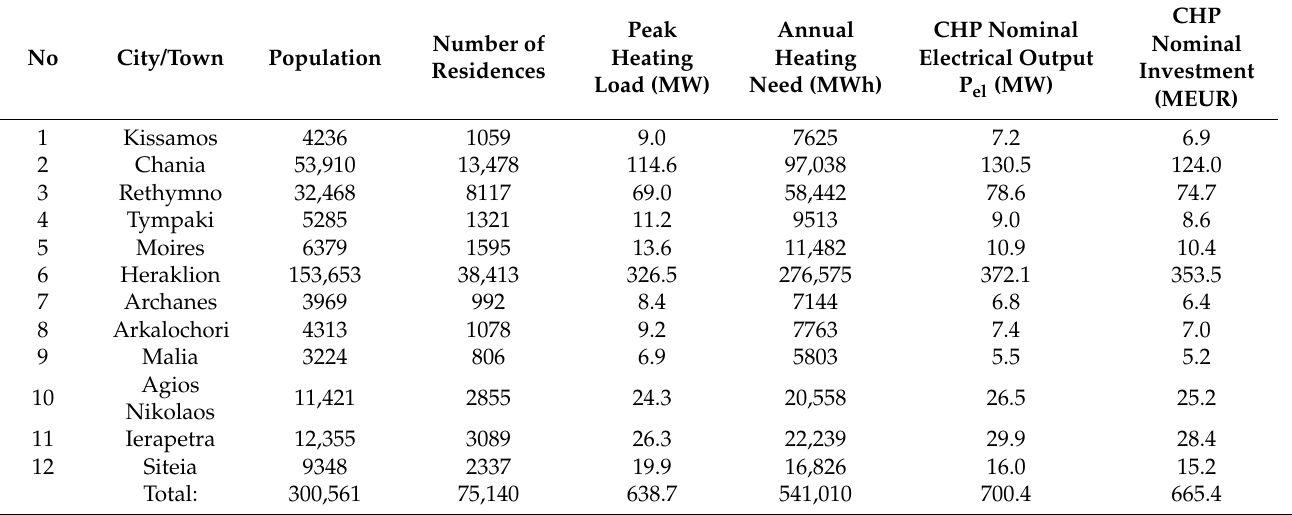
Table 6. Indicative dimensioning of biogas-fired CHP plants for the coverage of the residential heating needs of the 12 biggest cities and towns (population > 3000) of Crete Island, Greece.